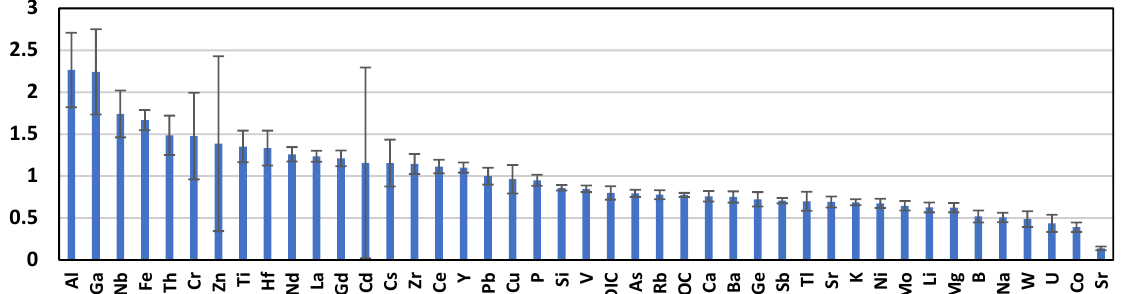
Figure 4. The ratio of the average ( ± s.d.) element concentrations of elements in the Ob River main stem downstream of the Irtysh (till the Ob mouth) to the concentration in the Irtysh River. Values above 1 indicate a sizable enrichment of the main stem in a given element by small tributaries in the north.